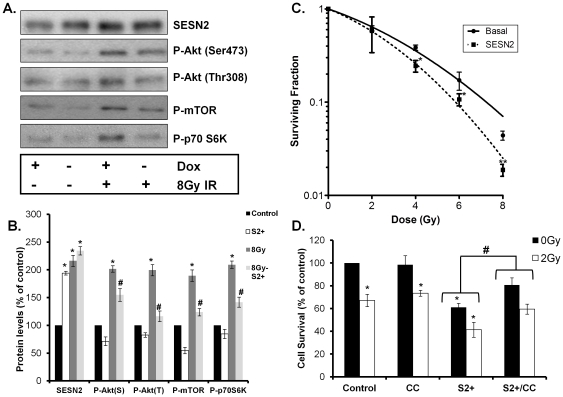
SESN2 in combination with IR modulates pathways of pro-survival and inhibits cell proliferation.(A) MCF7 Tet-OFF SESN2 cells were incubated in the presence (+) or absence (−) of Dox-containing medium for 24 h before exposure to 8Gy IR. Twenty four hours later the cells were lysed and subjected to western blotting with the indicated antibodies. A representative immunoblot from 3 independent experiments is shown. (B) The results from (A) were quantitated and expressed as the mean and SE from 3 independent experiments (* = P<0.05 compared to control and # = P<0.05 compared to 8Gy IR). (C) MCF7 Tet-OFF SESN2 cells were incubated in the presence (basal) or absence (SESN2) of Dox-containing medium for 24 h before exposure to the indicated doses of IR. Seven days later the cells were fixed and stained with mythelene blue and the clonogenic survival was calculated. Results from 3 independent experiments were averaged and presented as the mean and SE (* = P<0.05 and ** = P<0.01 compared to the corresponding IR treatment alone) and plotted on a logarithmic scale using the linear quadratic equation. The results were normalized so that both the untreated (basal) and SESN2 overexpressing cells (SESN2) start at the same point. (D) MCF7 Tet-OFF SESN2 cells were incubated in the presence (control) or absence (S2+) of Dox-containing medium and treated with or without 1 µM compound C (CC) for 24 h before exposure to 2Gy IR. Seven days later the cells were fixed and stained with mythelene blue and the clonogenic survival was calculated. Results from 3 independent experiments were averaged and presented as the mean and SE (* = P<0.05 compared to control and # = P<0.05 compared to S2+ alone).